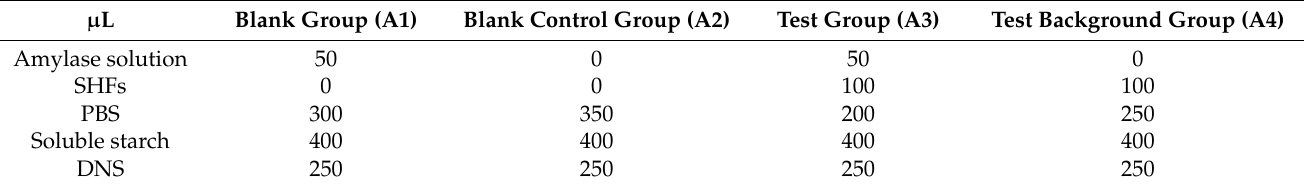
Table 2. Dosage table for α -AI activity assay of